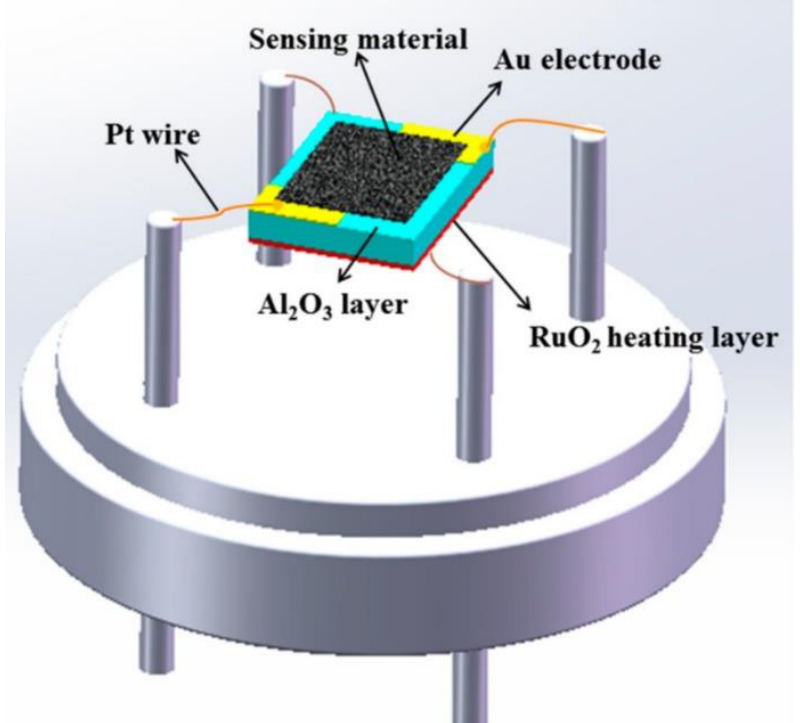
Figure 2. Schematic illustration of an MOS-based gas sensor, showing the sensing material, electrodes, and heater. Reprinted with permission from Ref. [20]. Copyright 2020, MDPI.